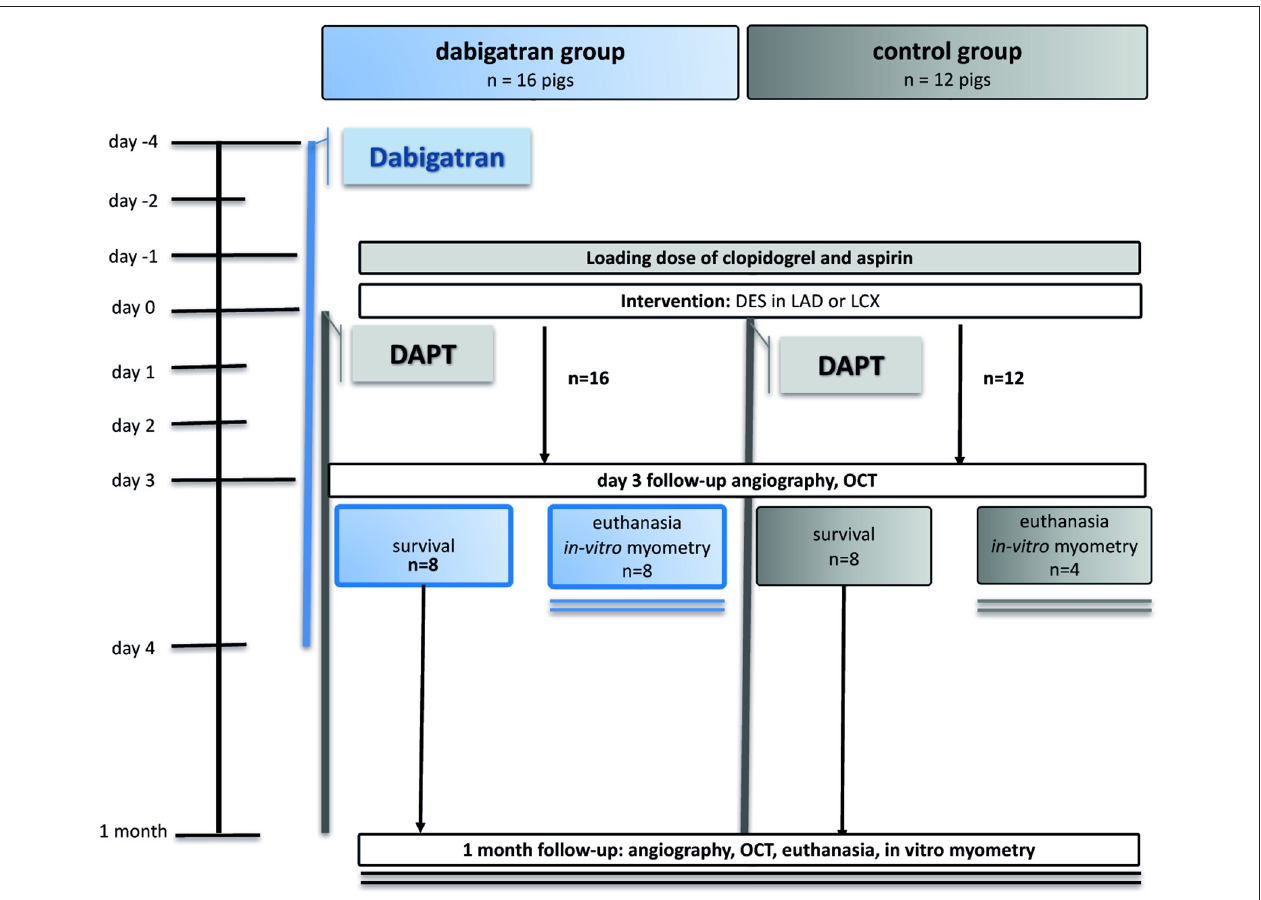
FIGURE 1 | Study design. DES, drug-eluting stent; LAD, left anterior descending coronary artery; LCx, left circumflex coronary artery; DAPT, dual antiplatelet therapy; OCT, optical coherence tomography.